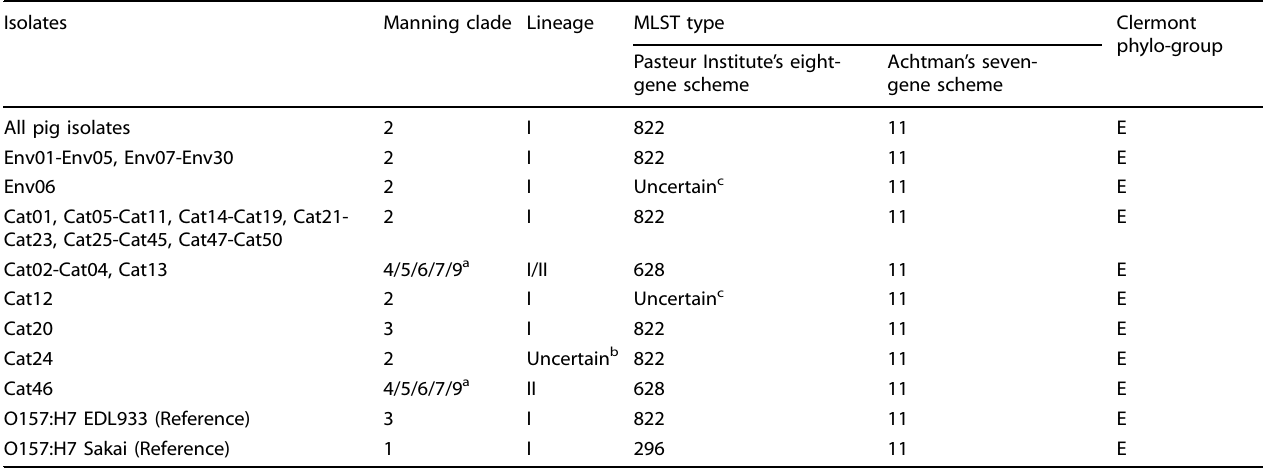
Table 1. The conventional subtyping of 121 E. coli O157:H7 isolates from various sources. Isolates